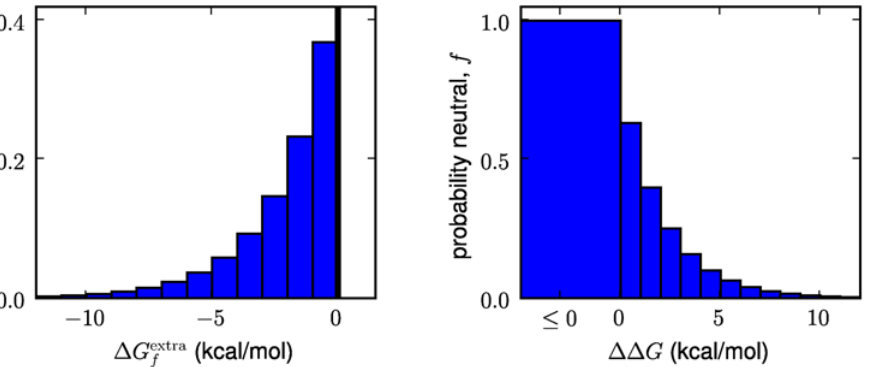
Figure 2. Stability distributions and fixation probabilities. The panel at left show the probability p o that a protein in an evolving population , as given by Equation 3. The panel at right shows the probability f that a mutation that causes a stability change of will have extra stability D G extra f DD G will be neutral, as given by Equation 4. The units for D G extra and DD G are arbitrary; for concreteness here we give them units of kcal/mol. f